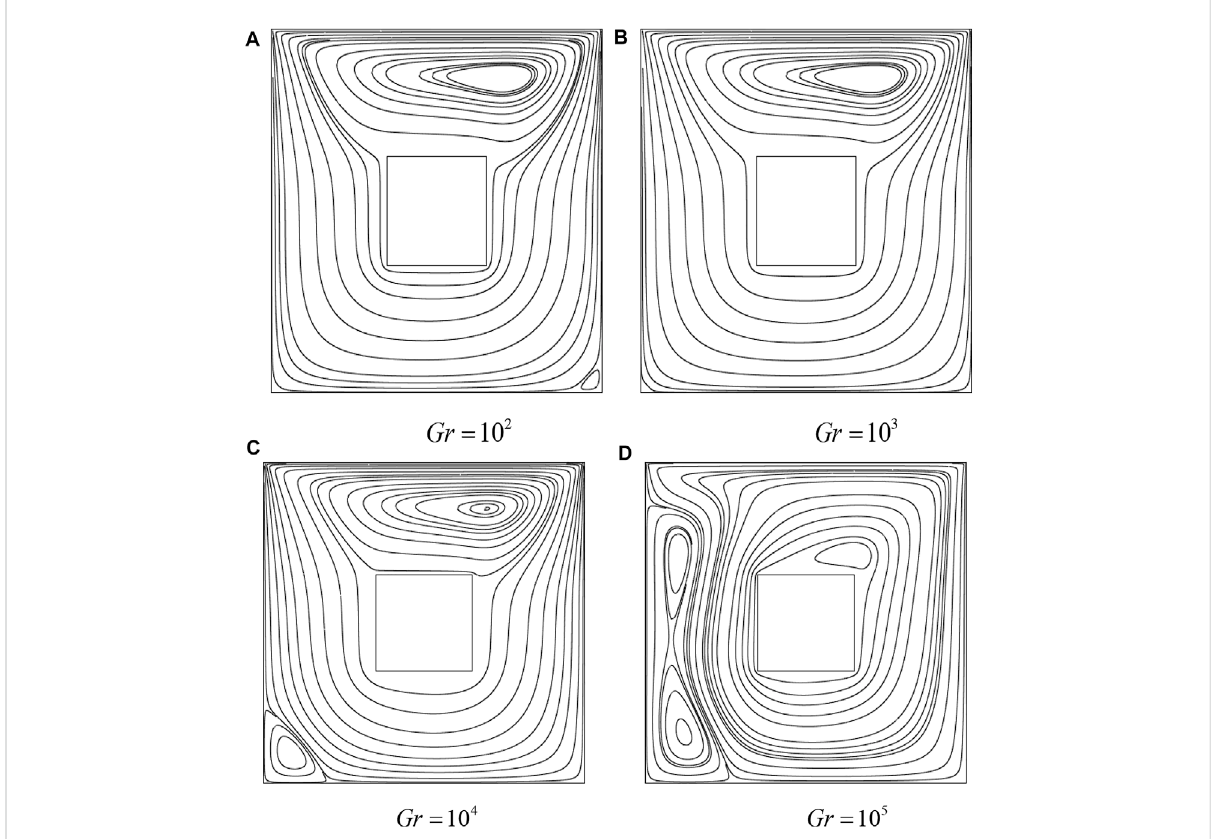
FIGURE 9 In fl uence of Gr on streamlines with a non-uniformly heated bottom wall: adiabatic cylinder with Ha (cid:2) 20 and Re (cid:2)